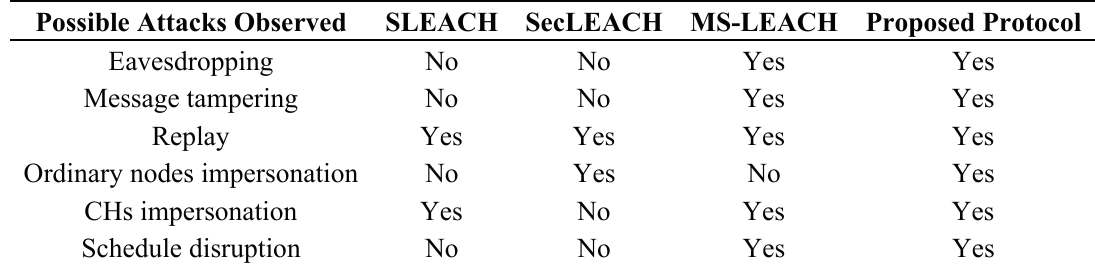
Table 3. Possible attacks addressed, in comparison with other secure routing